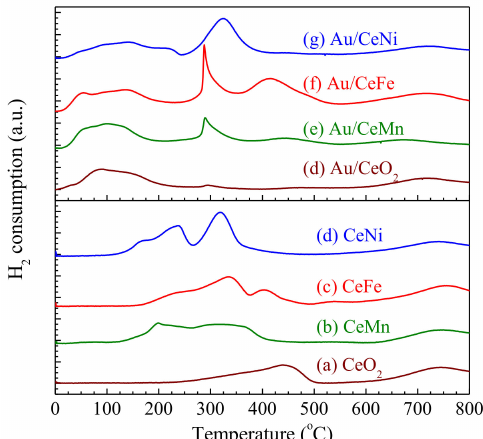
Figure 5. H 2 -TPR profiles of CeO 2 , CeM mixed oxides with different dopants and corresponding supported Au/CeM catalysts: ( a ) CeO 2 ; ( b ) CeMn; ( c ) CeFe; ( d ) CeNi; ( e ) Au/CeO 2 ; ( f ) Au/CeMn; ( g ) Au/CeFe; ( h )